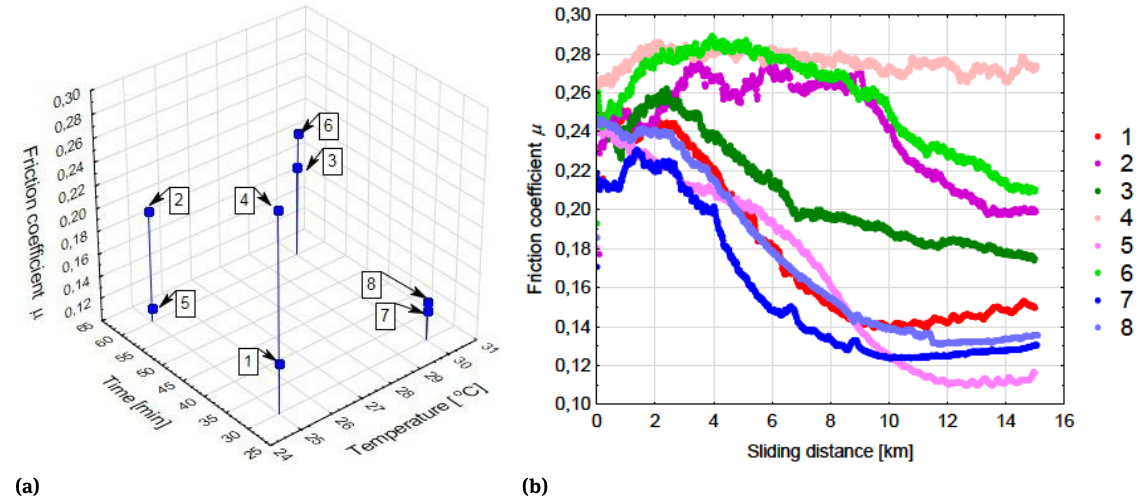
Figure 7: a) The scatter chart of friction coeflcient µ over time and temperature of anodizing process, b) diagram of friction coeflcient versus sliding